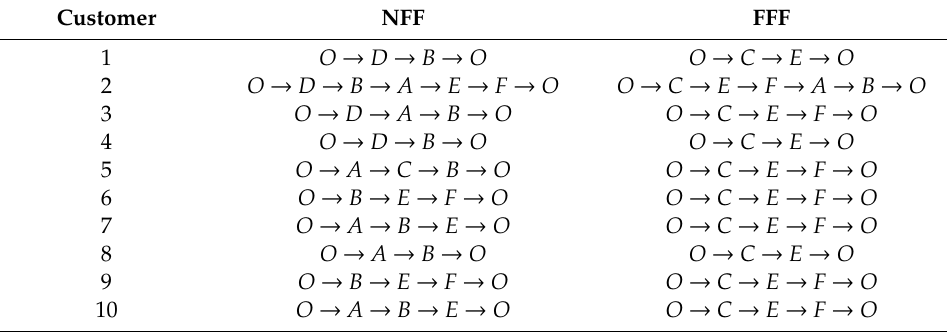
Table 12. Printing and delivery plans prepared using the two existing